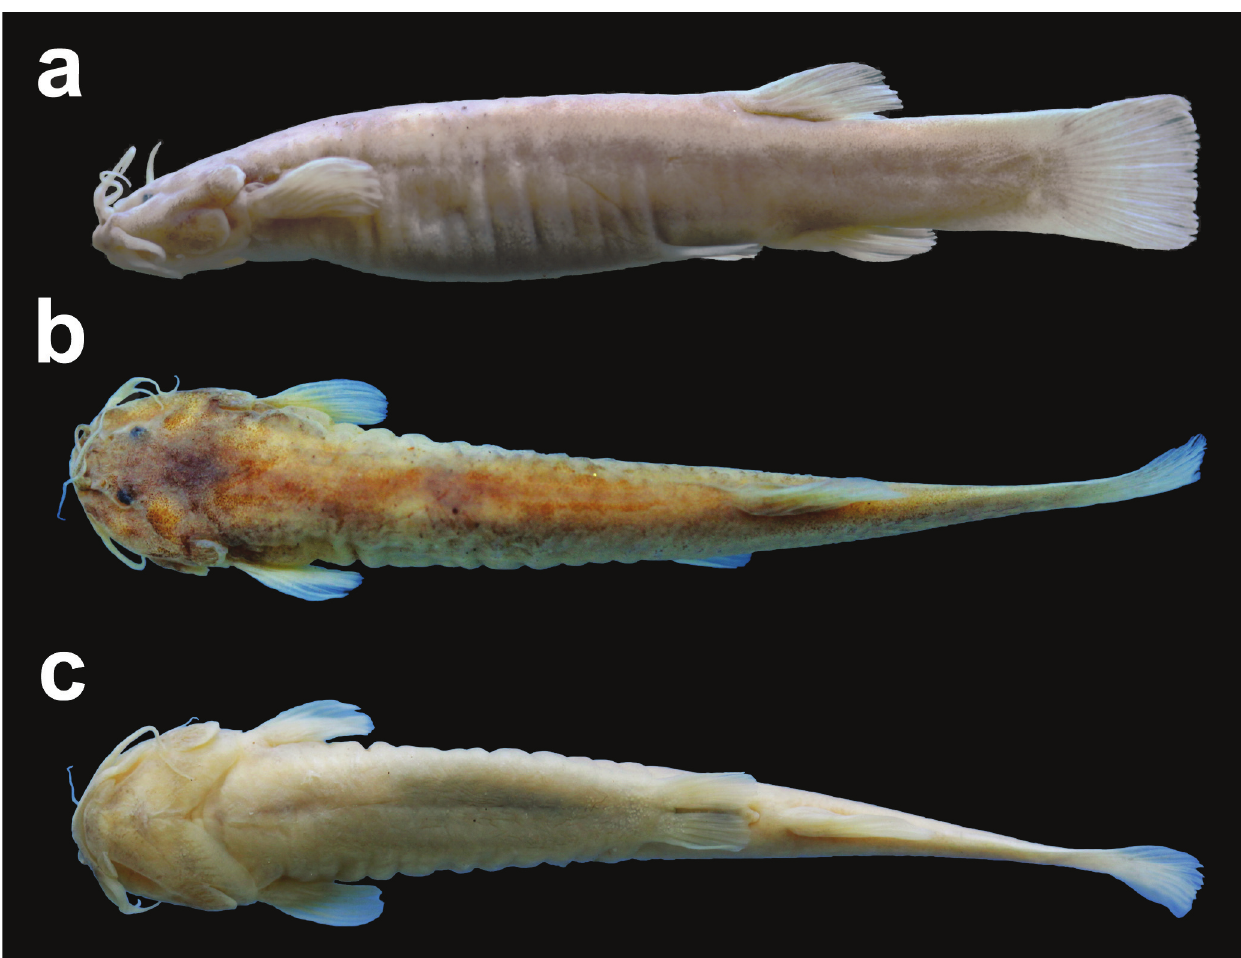
Table 1. Body slim, trunk compressed, caudal peduncle laterally compressed. Dorsal profile of body gradually ascending from tip of snout to anterior portion of trunk, approximately straight from that point to base of dorsal fin, descending along dorsal- fin base and straight on caudal peduncle until caudal fin. Ventral profile of head gently sloped. Ventral profile of body almost straight to shallowly convex. Head rounded anteriorly in dorsal view, small, and slightly depressed. Eyes small, orbital margin not free; thin skin covering eye. Anterior nostril surrounded by fleshy, tube- shaped flap of integument. Posterior nostril surrounded anteriorly by raised fleshy flap and located slightly closer to anterior nostrils than to eye. Mouth subterminal; lower lip contoured by fleshy lobe medial to origin of rictal barbels; upper lip with fleshy fold limited to base of maxillary barbel. Nasal barbel originating on lateral portion of integumentary flap around anterior nostril; tip of barbel reaching opercular odontode patch. Maxillary barbel reaching pectoral-fin origin. Rictal barbel extending to interopercular odontode